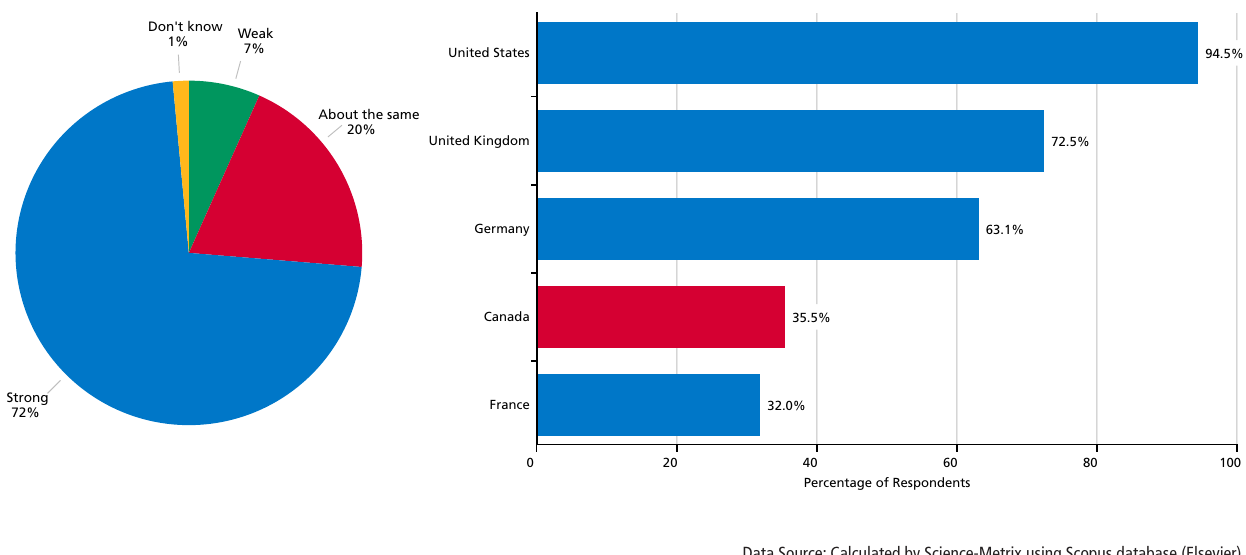
Survey Respondents’ Rating for Canada and Top-Five Countries